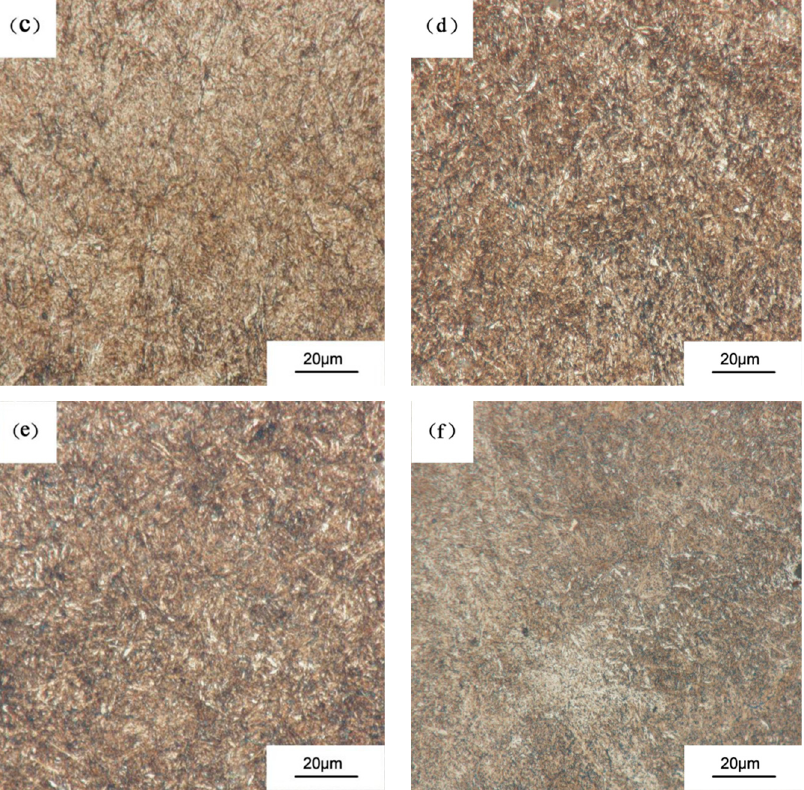
Figure 8. Microstructure of H13 steel after high temperature compression ( a ) 500 °C, ( b ) 600 °C, ( c ) 630 °C, ( d ) 6500 °C, ( e ) 670 °C, ( f ) 700 °C.